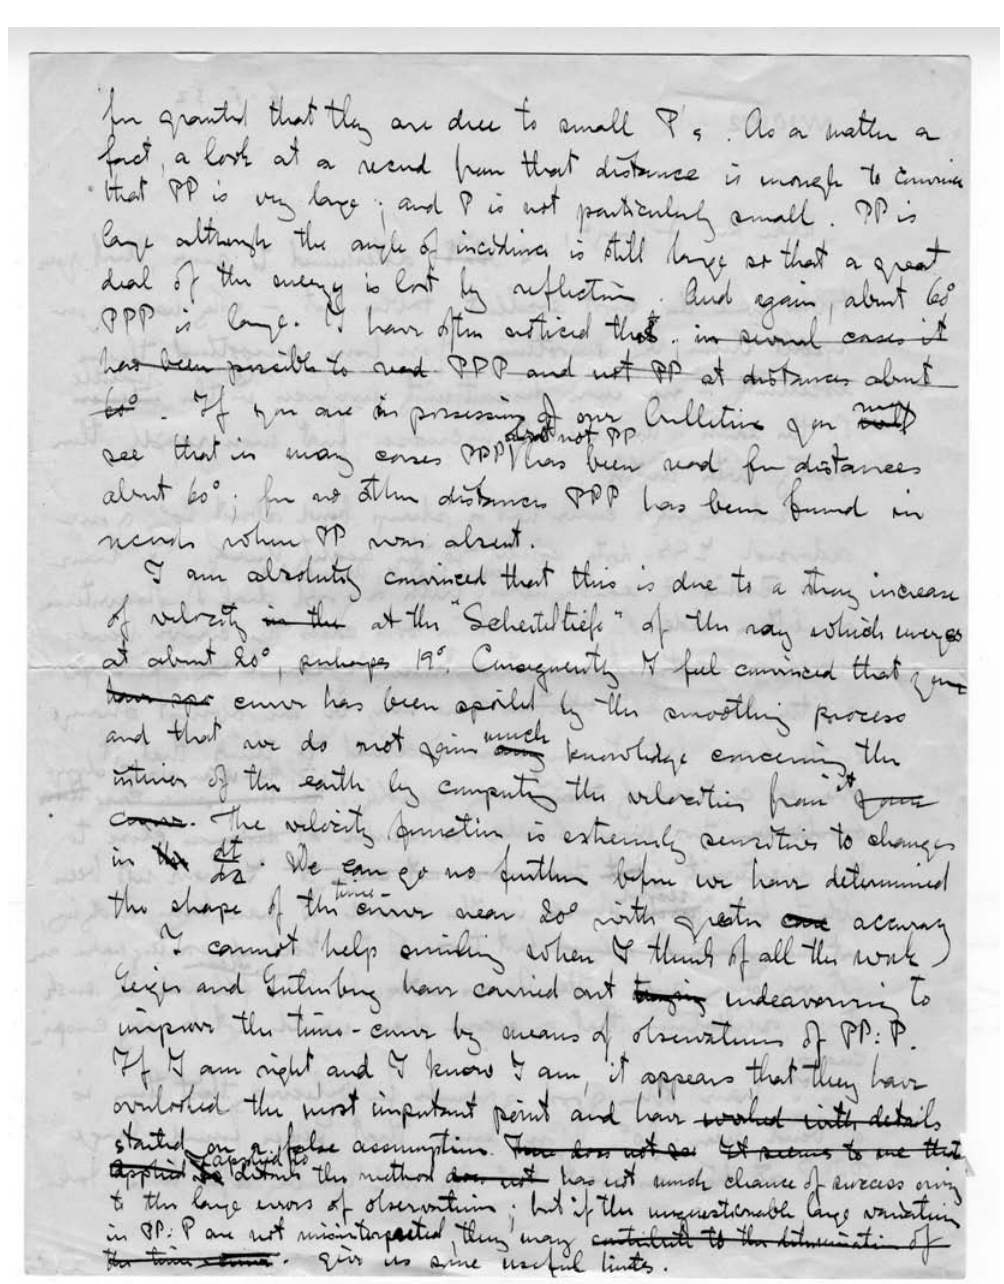
Fig. 7. Second page of Inge Lehmann’s May 6, 1932 letter to Harold Jeffreys. This paper was also shown in Potsdam 2004, and one of the words is German, Scheiteltiefe, the depth reached by the deepest